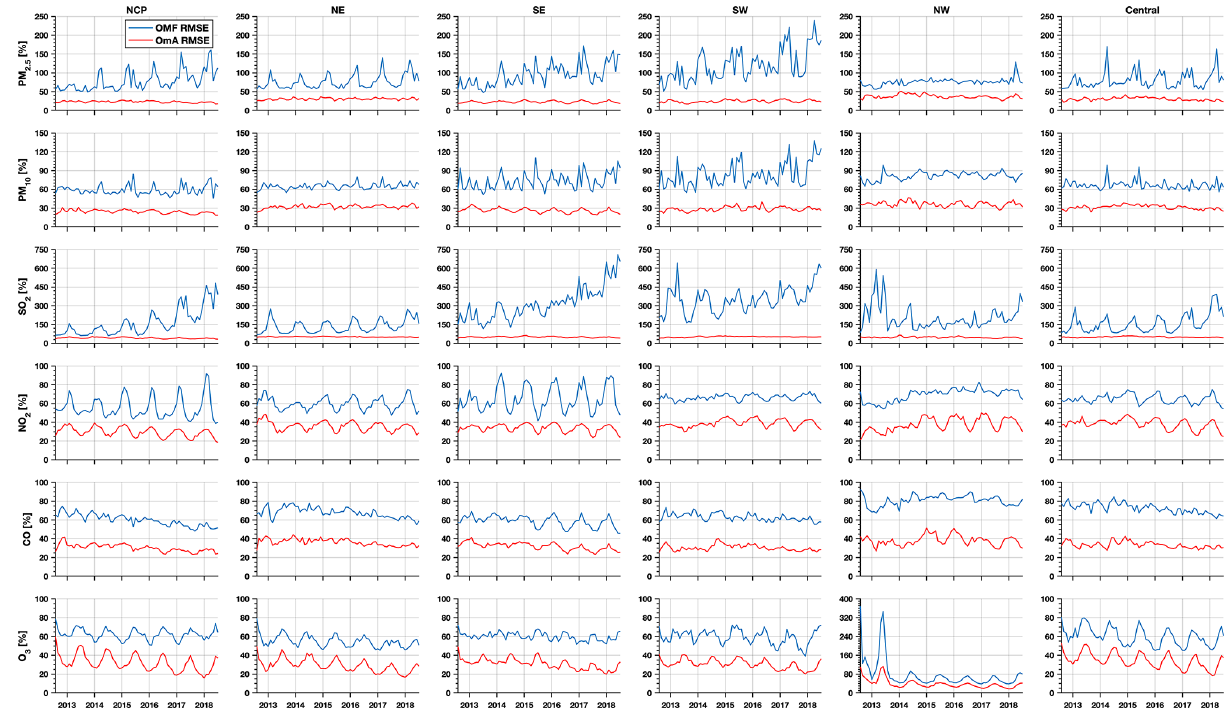
Figure C2. Time series of monthly mean OmF and OmA normalized root mean square error in different regions of China for different